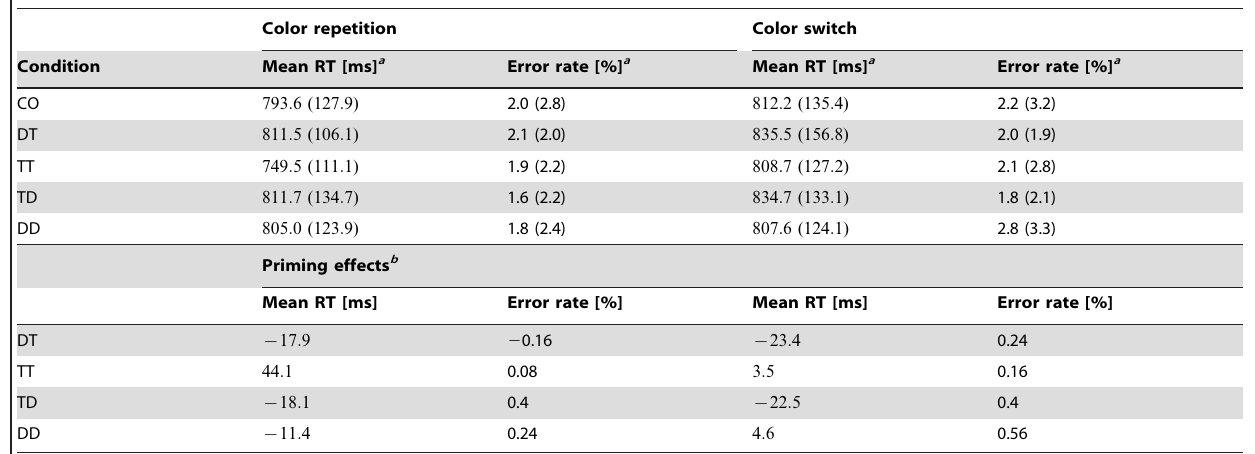
Table 2. Summary of results of Experiment 2.